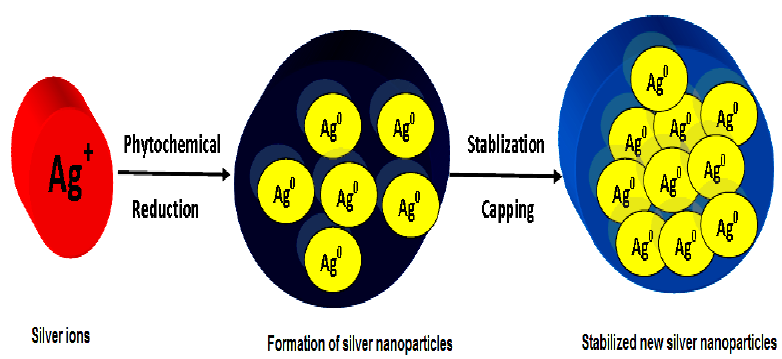
Fig. 5. The schematic representation of formation of silver nanoparticles from the plant